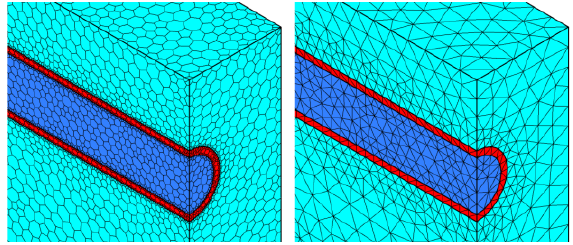
Fig. 4. Exemplary POLY (left) and TETRA (right) meshes The output mesh quality analysis provided a composite metric that ranges between 0 and 1 according to formula (1). A value of 1 indicates a perfect element while a value of 0 indicates that the element has a zero or negative volume. The element of the worst quality generated throughout the entire research (eight meshes) was characterized by the quality index of 0.11 and therefore it was assumed that the mesh did not affect the numerical stability of the computational